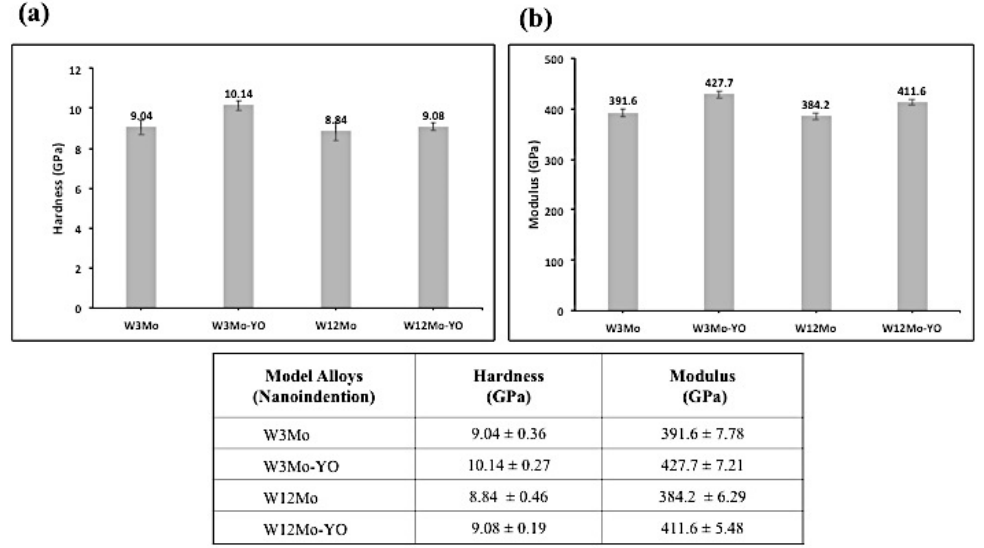
Figure 9. Nanoindentation measurements of the hardness and elastic modulus of the model alloys.